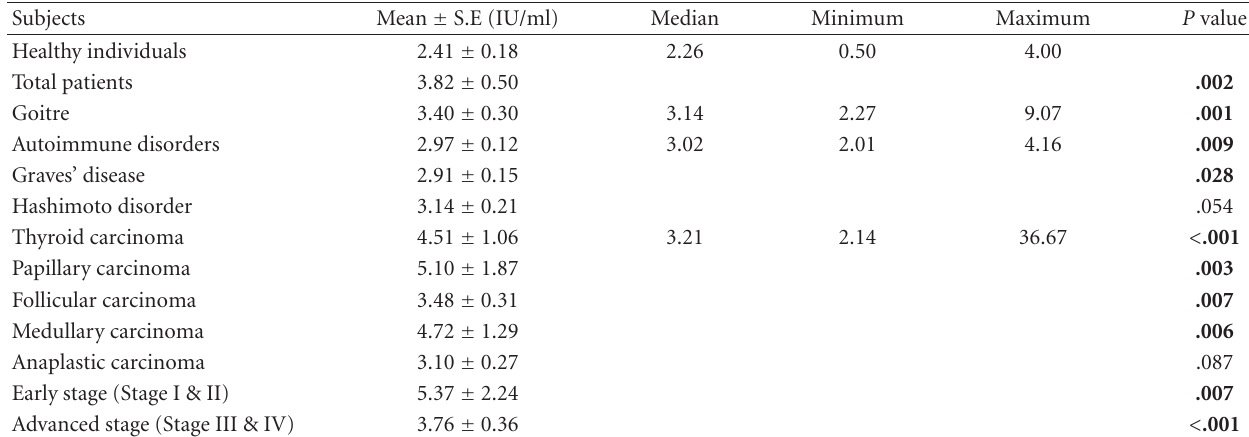
Table 4: Significance of IFN- α levels in patients with thyroid diseases as compared to healthy individuals. Subjects Mean ± S.E (IU/ml) Median Minimum Maximum P value Healthy